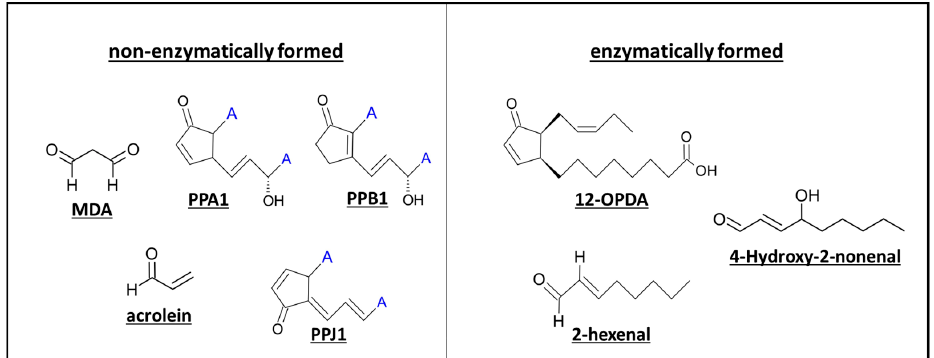
Figure 4. Structure of different α , β -unsaturated carbonyl oxylipins. Oxylipins of different synthesis pathways (phytoprostanes (PP), MDA, acrolein (non-enzymatic synthesis), 12-OPDA (AOS pathway), and 2-hexenal, 4-hydroxy-nonenal (HPL pathway)) contain a reactive α , β -unsaturated carbonyl compound and can thus participate in Michael addition.